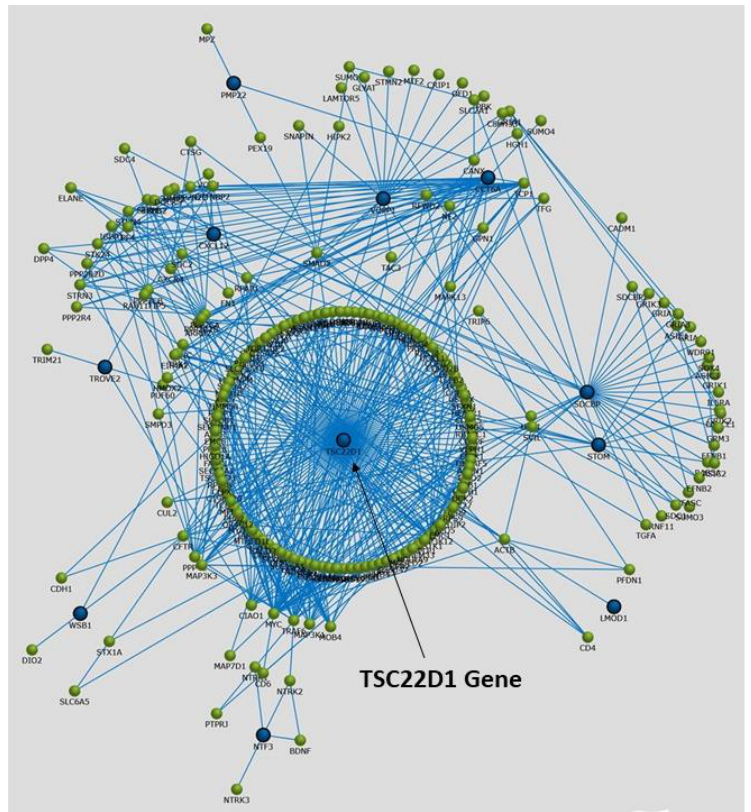
Figure 8. Graphical representation of enrichment analysis and interaction networks obtained through the FunRich database analysis tool for gene annotation pertaining to transcript expression associations in SKM tissue.